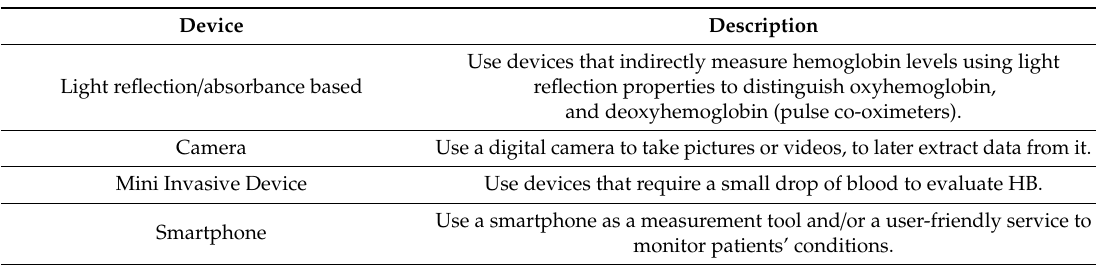
Table 5. Assessment goals’ definitions. Assessment Goal